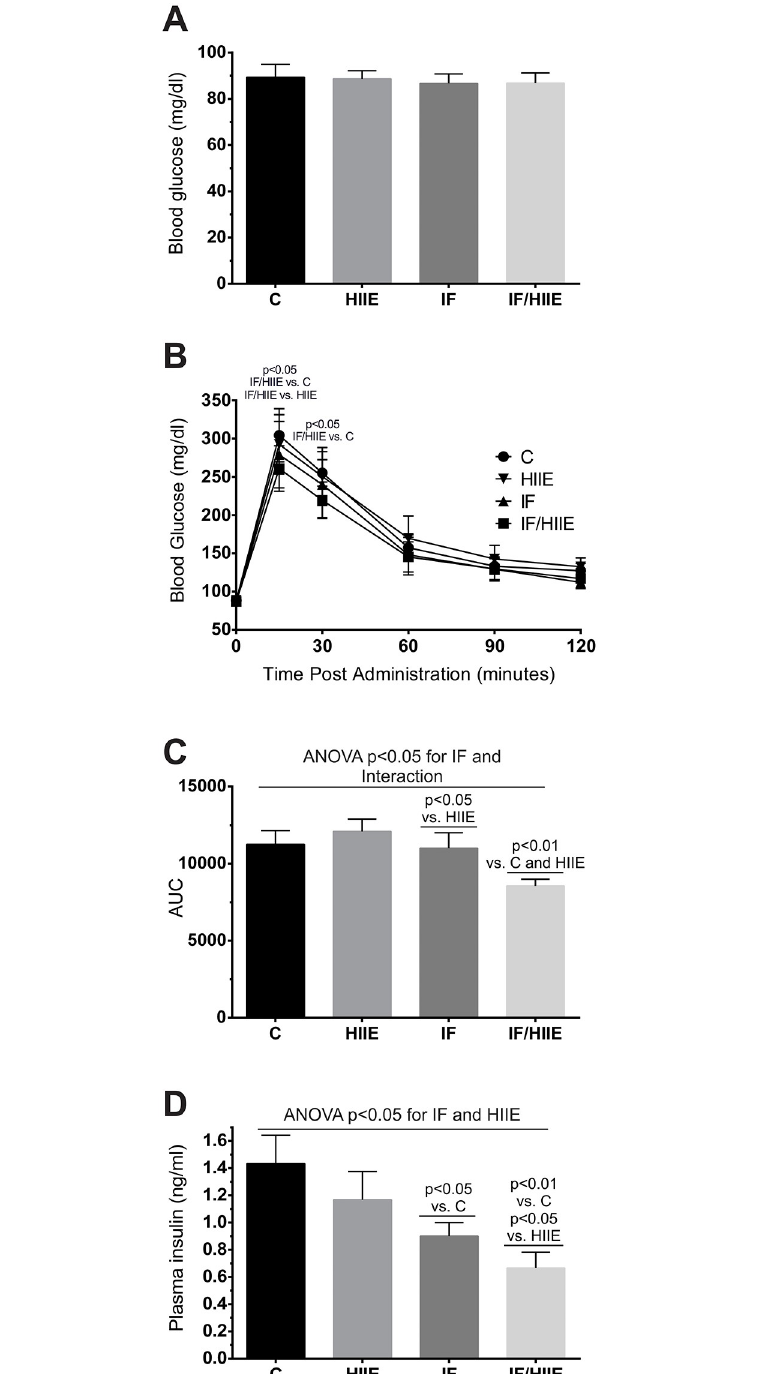
Fig 3. IF/HIIE present enhanced glucose tolerance and lower levels of fasting plasma insulin. (A) Plasma blood glucose levels. (B) IGTT. Animals were fasted for 12 h prior to the administration of an intraperitoneal injection of glucose (2 g/kg bw). (C) AUC calculated from IGTT curve (B). (D) Insulin plasma levels of fasted animals were measure using an Elisa-based method. Each bar represents the mean ± SD; A-D) n = 6. Individual effects (IF and HIIE) and the effect of their interaction were verified by two-way ANOVA and multiple comparisons; p values were annotated.